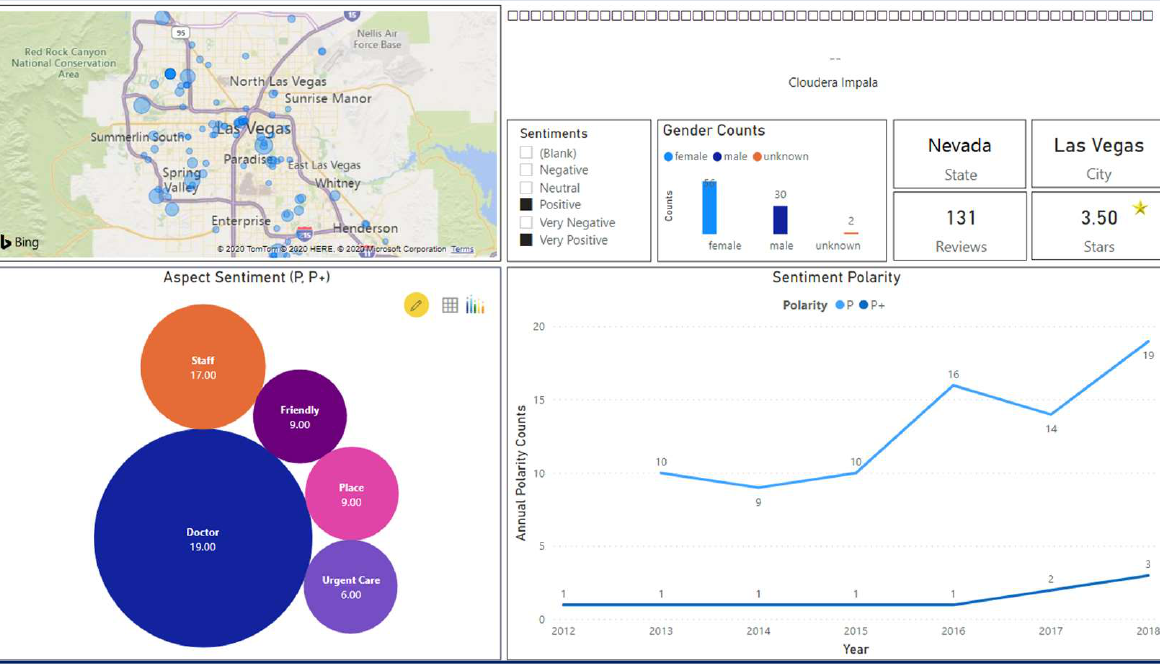
Figure 13. Positive sentiment aspects.